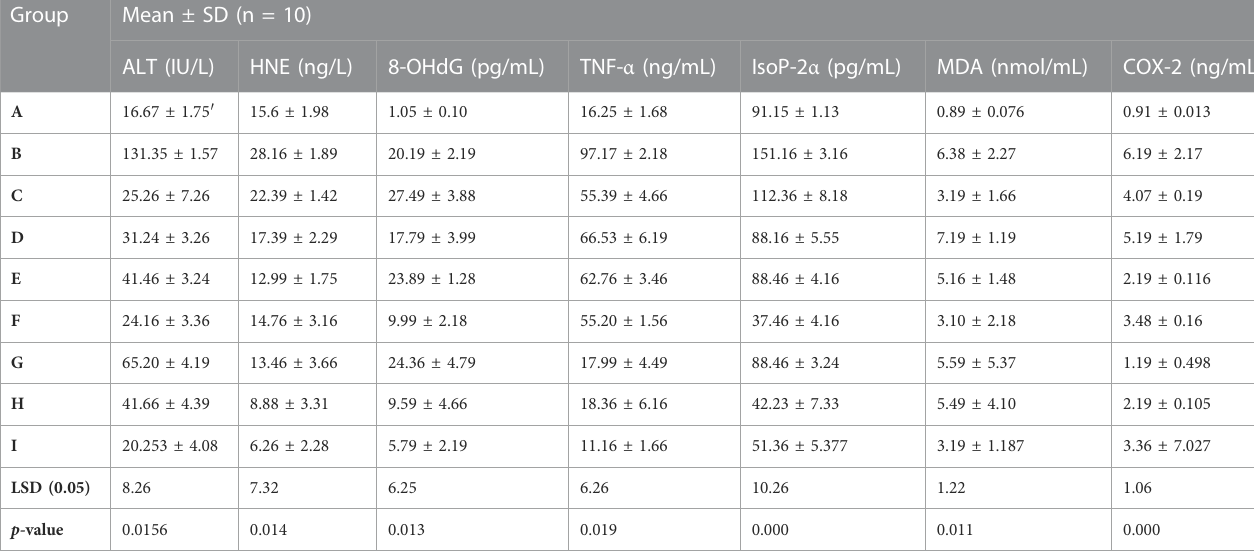
TABLE 5 Biochemical response of luteolin, epiafzelechin, and albigenin in rats stimulated with Cd.